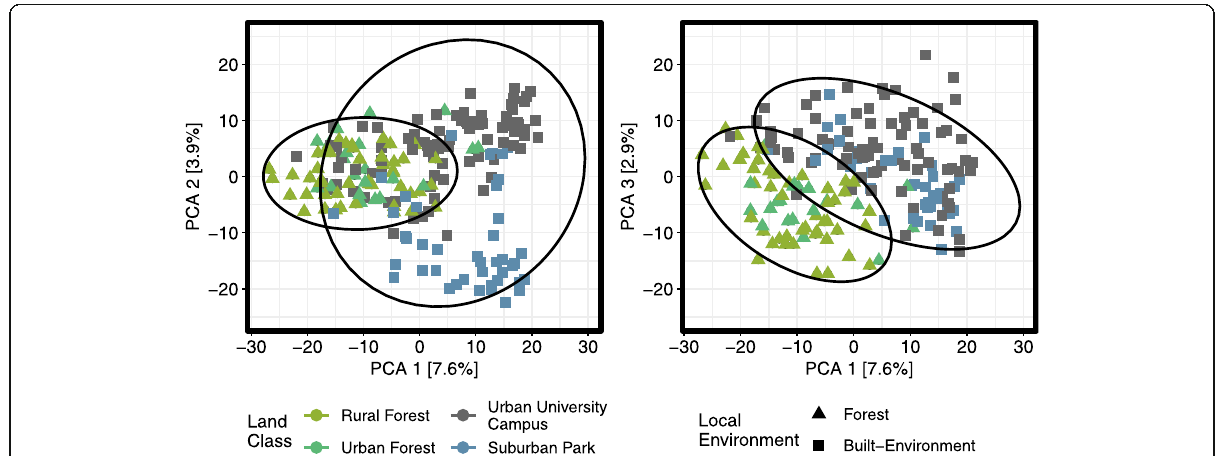
Fig. 3 The first three axes of a principal coordinate analysis ordination of Euclidean distances (centred log-ratio transformed OTU dataset) separating eastern grey squirrel microbiomes. Points coloured by land class and shaped by local environment type (forest versus built- environment). Solid lines denote 95% confidence ellipses around environment